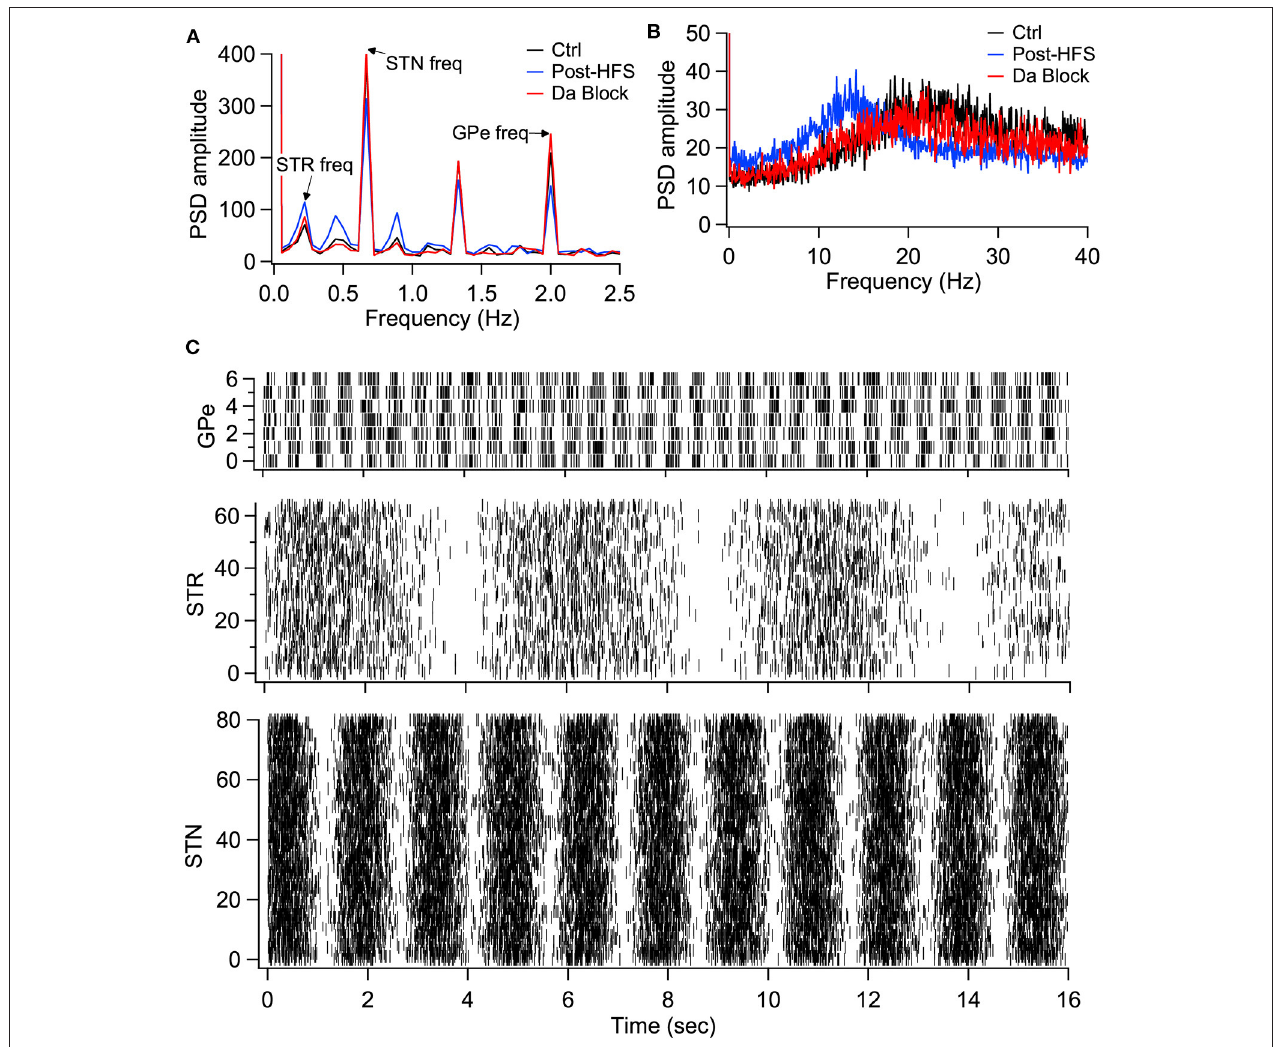
FIGURE 9 | Model simulations demonstrate the eCB dependent synaptic plasticity enhances information transmission from the striatum and reduces energy in the β band. (A) Simulations in response to oscillatory synaptic inputs reveals that Post-HFS enhances energy at the Str frequency while reducing energy at GPe and STN frequencies. N = 15 trials. (B) Simulations in response to log normally distributed synaptic inputs demonstrates that Post-HFS shifts energy into the β -band, whereas blocking dopamine during Post-HFS does not change energy in the β -band. N = 15 trials. (C) Raster plots of synaptic inputs for 1 trial of simulations in (A) . Oscillation frequency of 0.2Hz (Str), 0.6Hz (STN), and 2Hz (GPe) modulates the mean firing frequency of synaptic inputs. Note that mean firing frequency of synaptic inputs was 4Hz (Str), 18Hz (STN), and 29.3Hz (GPe) for both oscillatory (A) and log normally distributed (B)